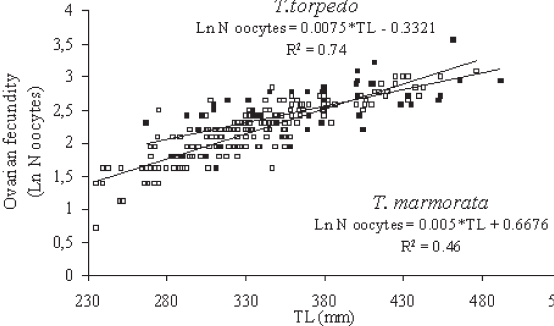
F IG . 7. – Relationship between ovarian fecundity and total length in T. torpedo ( (cid:2) ) and T. marmorata ( (cid:3) ).